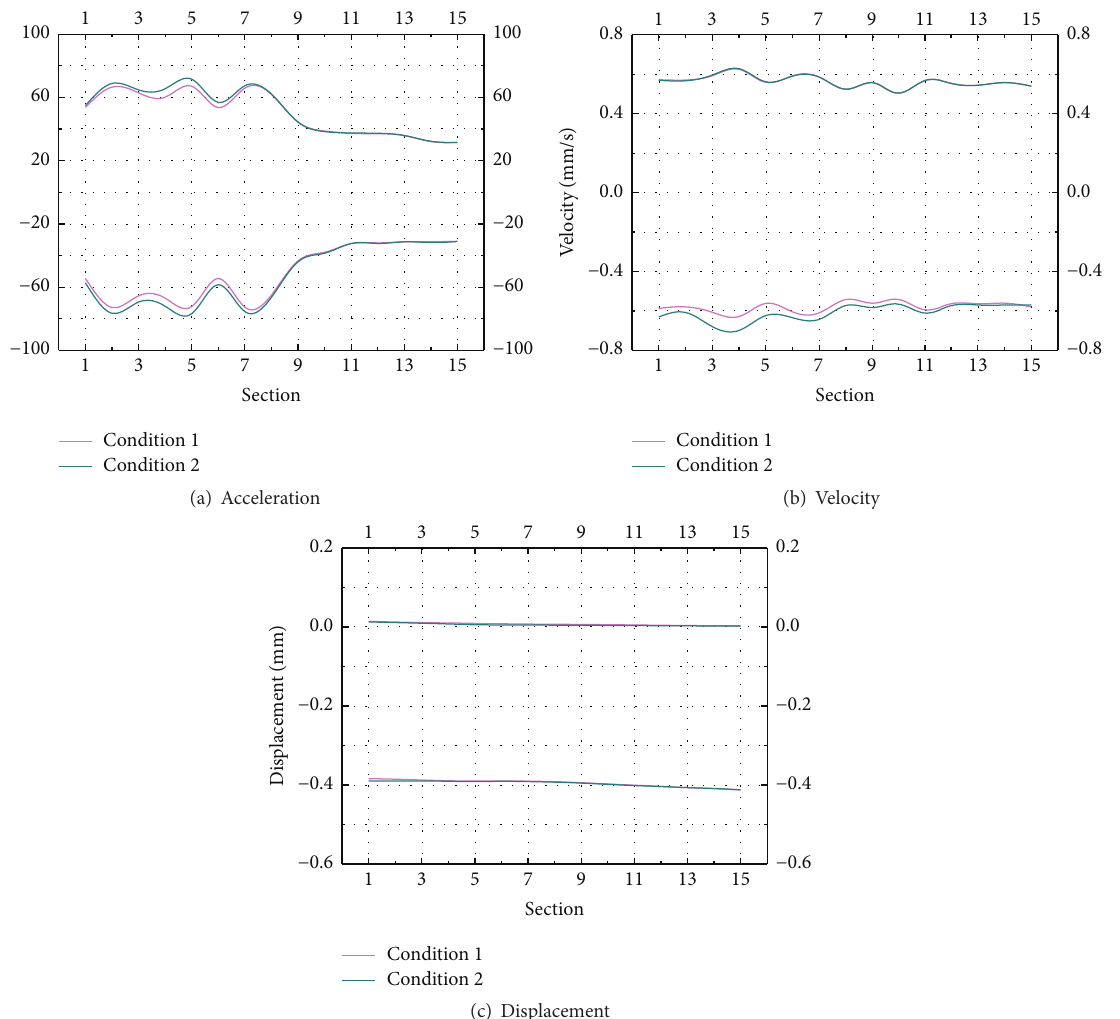
Figure 10: The maximum and minimum values of point C in two conditions: (a) acceleration, (b) velocity, and (c)